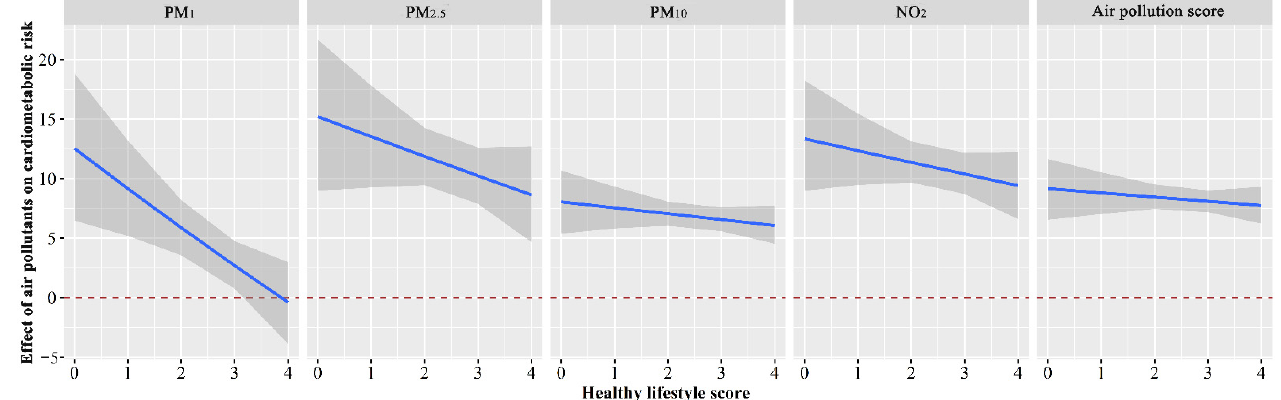
Figure 2. The estimated associations of ambient air pollutants (PM 1 , PM 2.5 , PM 10 , NO 2 , and the air pollution score) on the cardiometabolic risk score as a function of the healthy lifestyle score were analyzed using generalized linear models. Models were adjusted for age, gender, marital status, educational level, personal averaged monthly income, family history of CHD, family history of stroke, family history of T2DM, and family history of hypertension. The X ‐ axis represents the healthy lifestyle score. The Y ‐ axis represents the estimated effects and the 95% confidence intervals of ambient air pollutants on the cardiometabolic risk score along with the altered healthy lifestyle score. The blue lines and the grey areas represent the estimated effect and the 95% confidence interval. Abbreviation: PM 1 , particulate matter with an aerodynamics diameter of ≤ 1.0 μ m; PM 2.5 , partic ‐